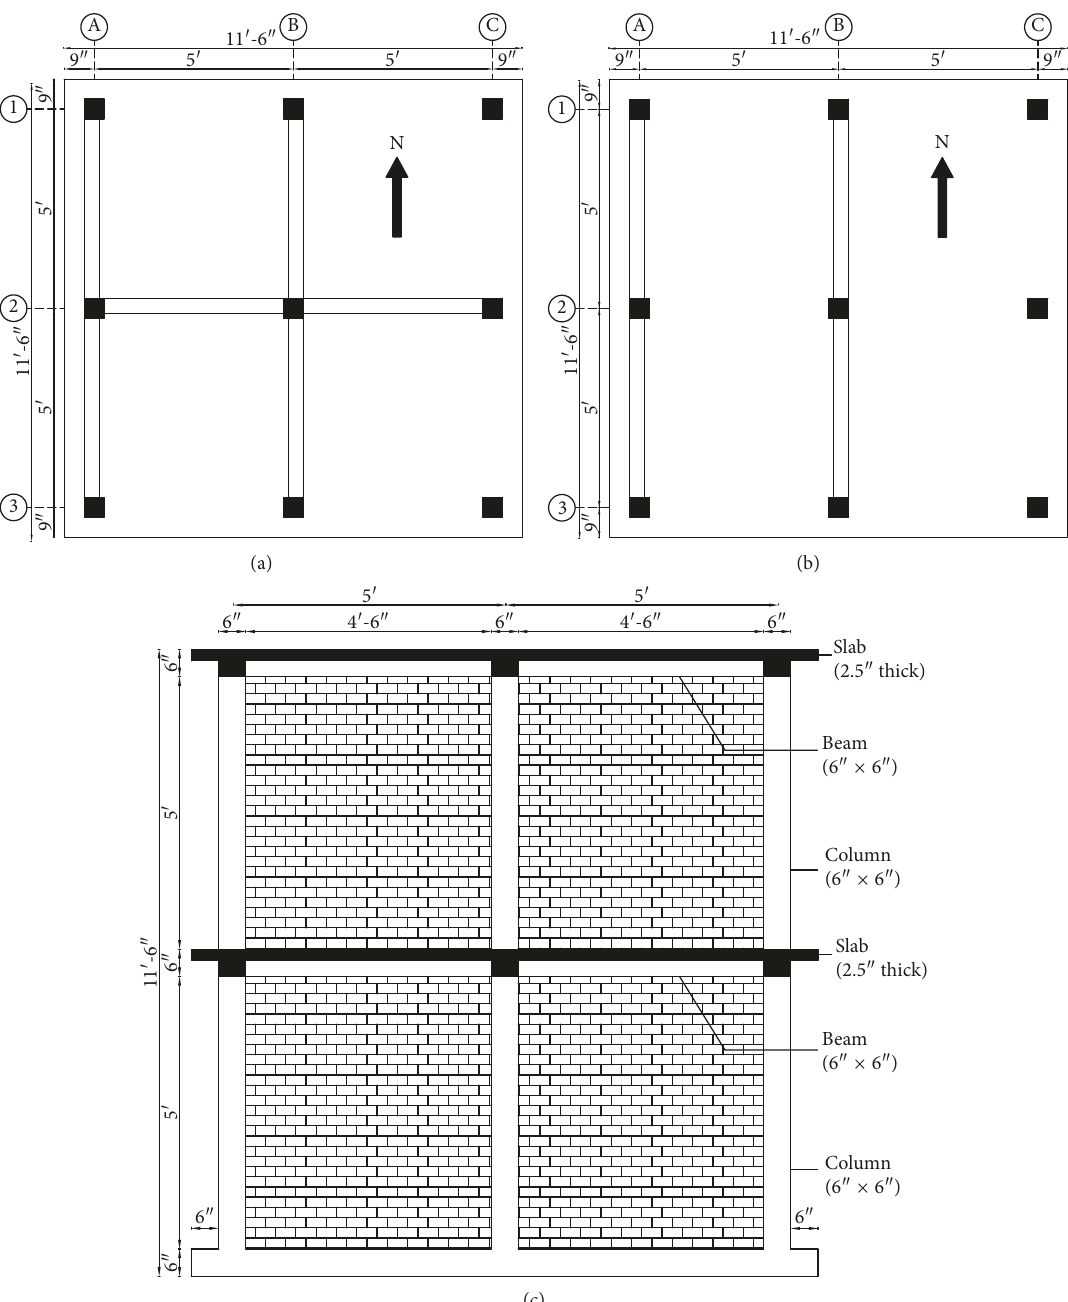
Figure 3: Plan and elevation view of the test specimen. (a) First-storey wall layout plan. (b) Second-storey wall layout plan. (c) Elevation view of the interior